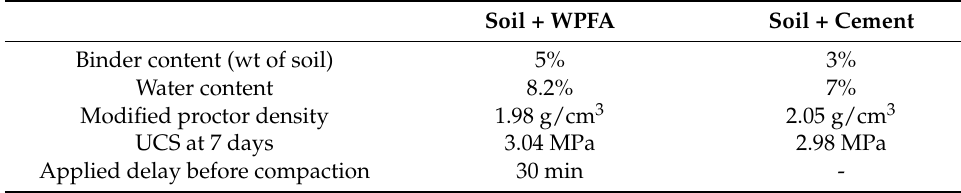
Table 3. Test design parameters for soil stabilization.